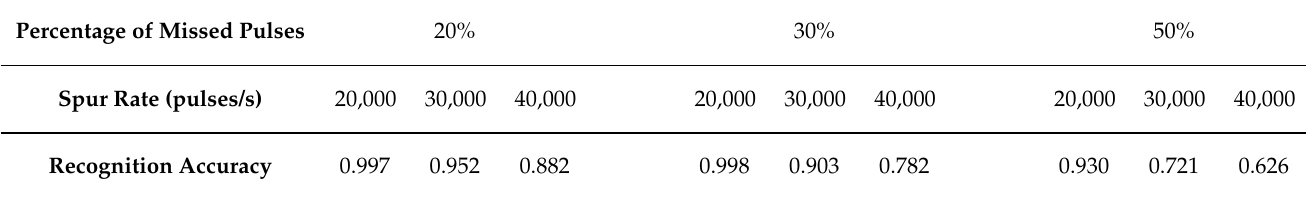
Table 2. Summary of the performance results of the radar word recognition